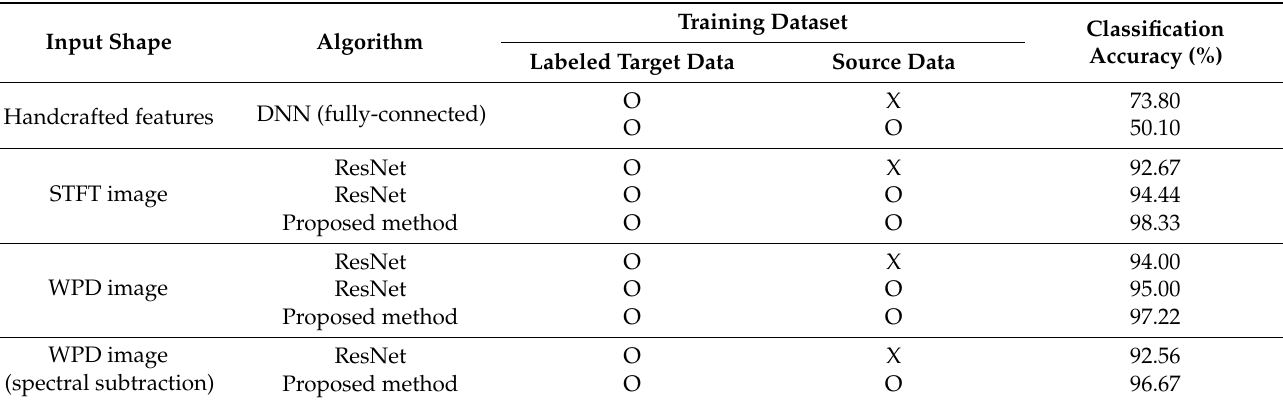
Table 3. Comparison results of each